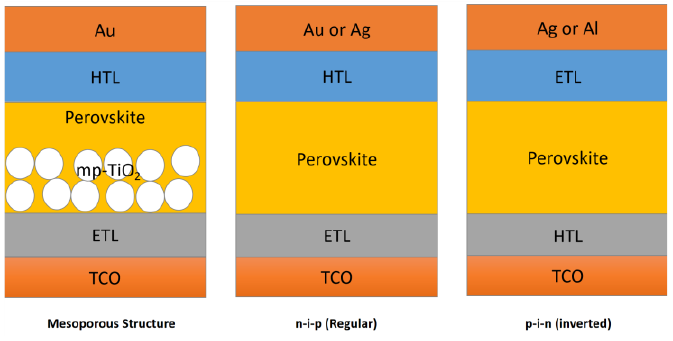
Figure 6. The device structure of PSCs.